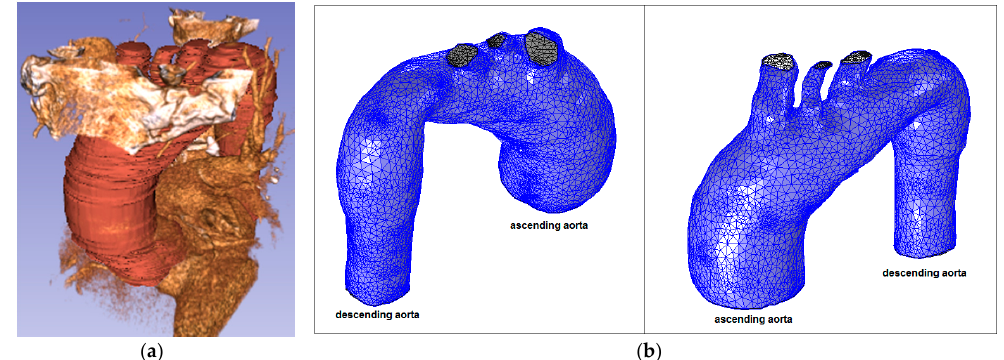
Figure 7. Ascending aorta aneurysm (Patient 2): ( a ) CT data and segmentation; and ( b ) mesh.